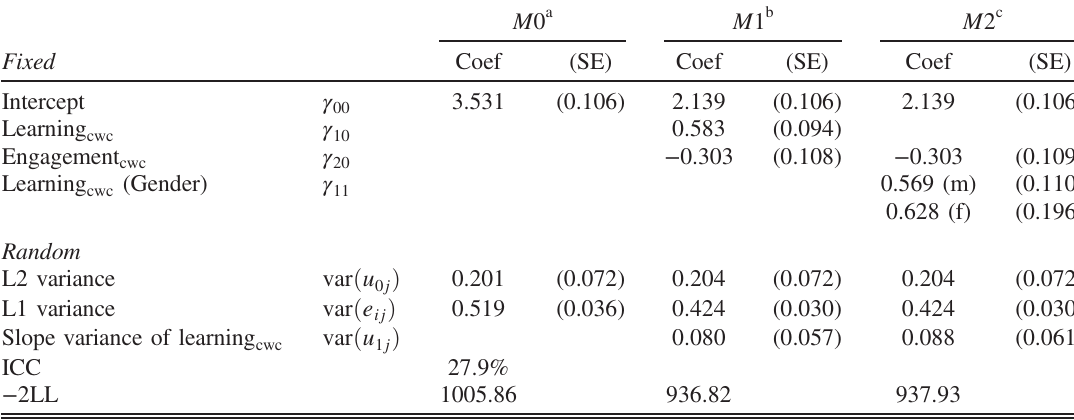
TABLE III. Detractors as the outcome for three different models. The values are all statistically significant ( p < 0 . 05 ), the significance of slope variance was tested with chi-square test using − 2 LL.